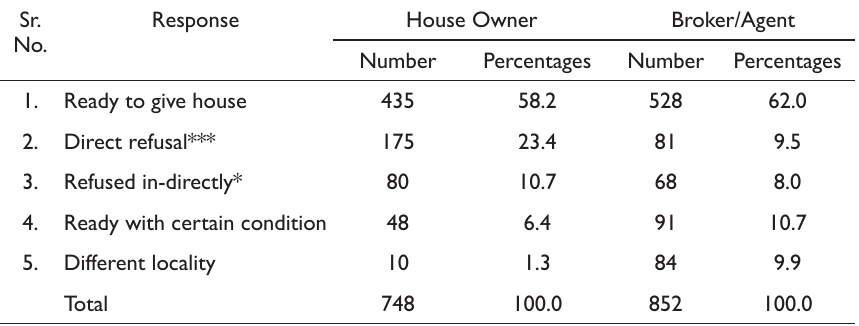
Table 8. Total Response to Auditors in Delhi by House Providers (Telephonic) Sr.